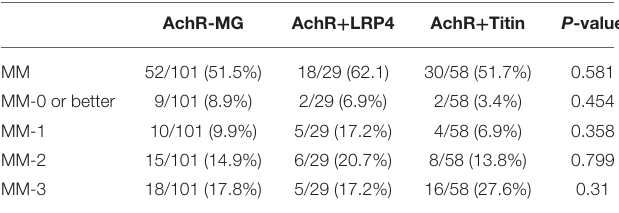
TABLE 2 | Comparison of the prognosis after immunosuppressive therapy among AchR-MG, AchR + LRP4 and AchR + Titin MG.